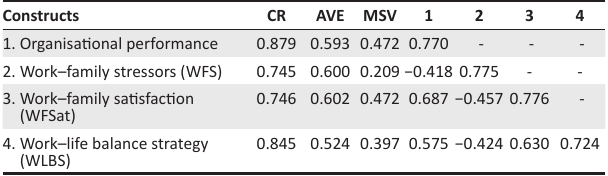
TABLE 2: Reliability analysis, convergent and discriminant validity assessment.